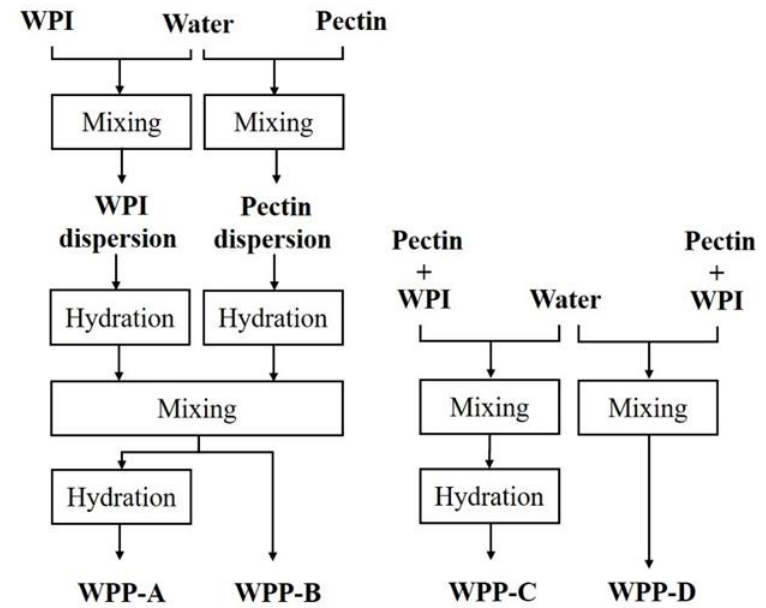
Figure 2. Flow chart of the four methods (A–D) of whey protein pectin (WPP) dispersion preparation with different combinations of hydration ( ϑ = 8 °C, t = 24 h) and mixing steps (A: standard dispersion preparation).